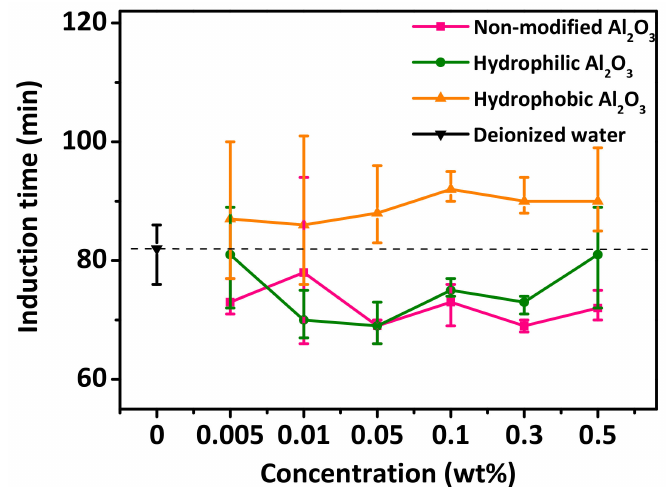
Figure 9. E ff ects of the di ff erent concentrations and types of Al 2 O 3 nanoparticles on the kinetics of CO 2 hydrate formation. The induction time versus the dispersed solution